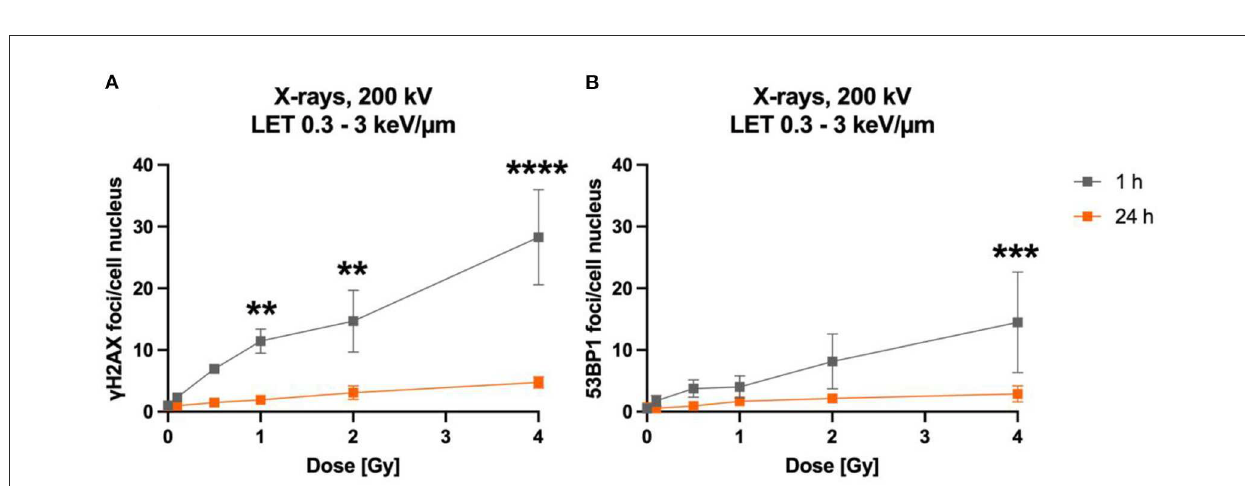
FIGURE2 The number of γ H2AX and 53BP1 foci formed in X-irradiated astrocytes increases dose-dependently. Astrocytes were mock-irradiated (0Gy) or irradiated with X-ray doses (200 kV, 15mA) up to 4Gy and fixed 1 and 24h after irradiation for immunofluorescence staining of the DNA double strand marker γ H2AX (A) and the DNA repair protein 53BP1 (B) . The number of foci ( γ H2AX, 53BP1) per cell nucleus was quantified to generate dose effect curves of the initial foci number (1h) and the number of foci after a repair time of 24h. The sample size was n = 3 for both immunofluorescence stainings. The samples were compared via 2way ANOVA (Tukey’s multiple comparisons test), based on a sample size n = 3. Data are shown as mean ± SD. In case that the error bars are smaller than the symbol, they are not visible. Significant differences in comparison to the respective 0Gy control are indicated by asterisks (** p < 0.01, *** p < 0.001, **** p <